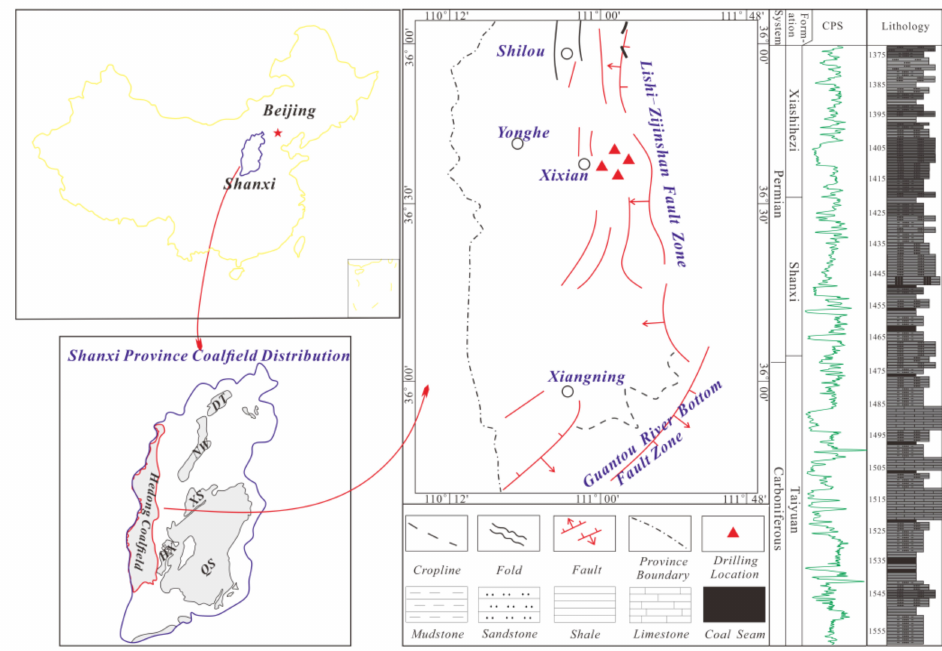
Figure 1. The structural outline map of the Hedong Coalfield and the Taiyuan–Shanxi Formations’ drilling lithology, where DT is the Datong coalfield, QS is the Qinshui coalfield, HX is the Huoxi coal field, NW is the Ningwu coalfield, XS is the Xishan coalfield, CPS is one of the Logging curve types (ANEC APS Near Detector Counts).